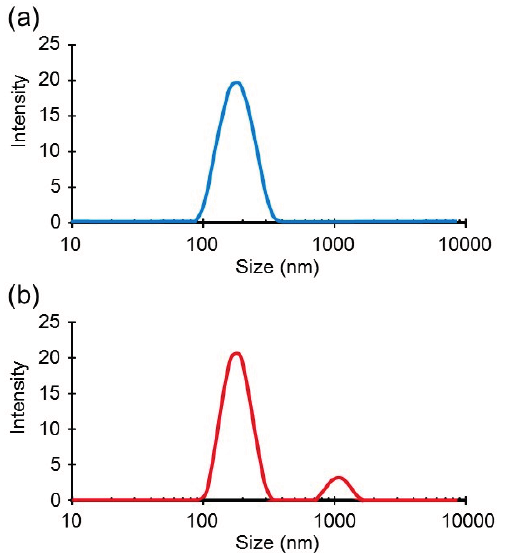
Figure 3. Size distribution profiles of the DNA/(PEI “Max”)/HA complexes (1:12:12) ( a ) before and ( b ) after lyophilization under the presence of 0.1% dextran.